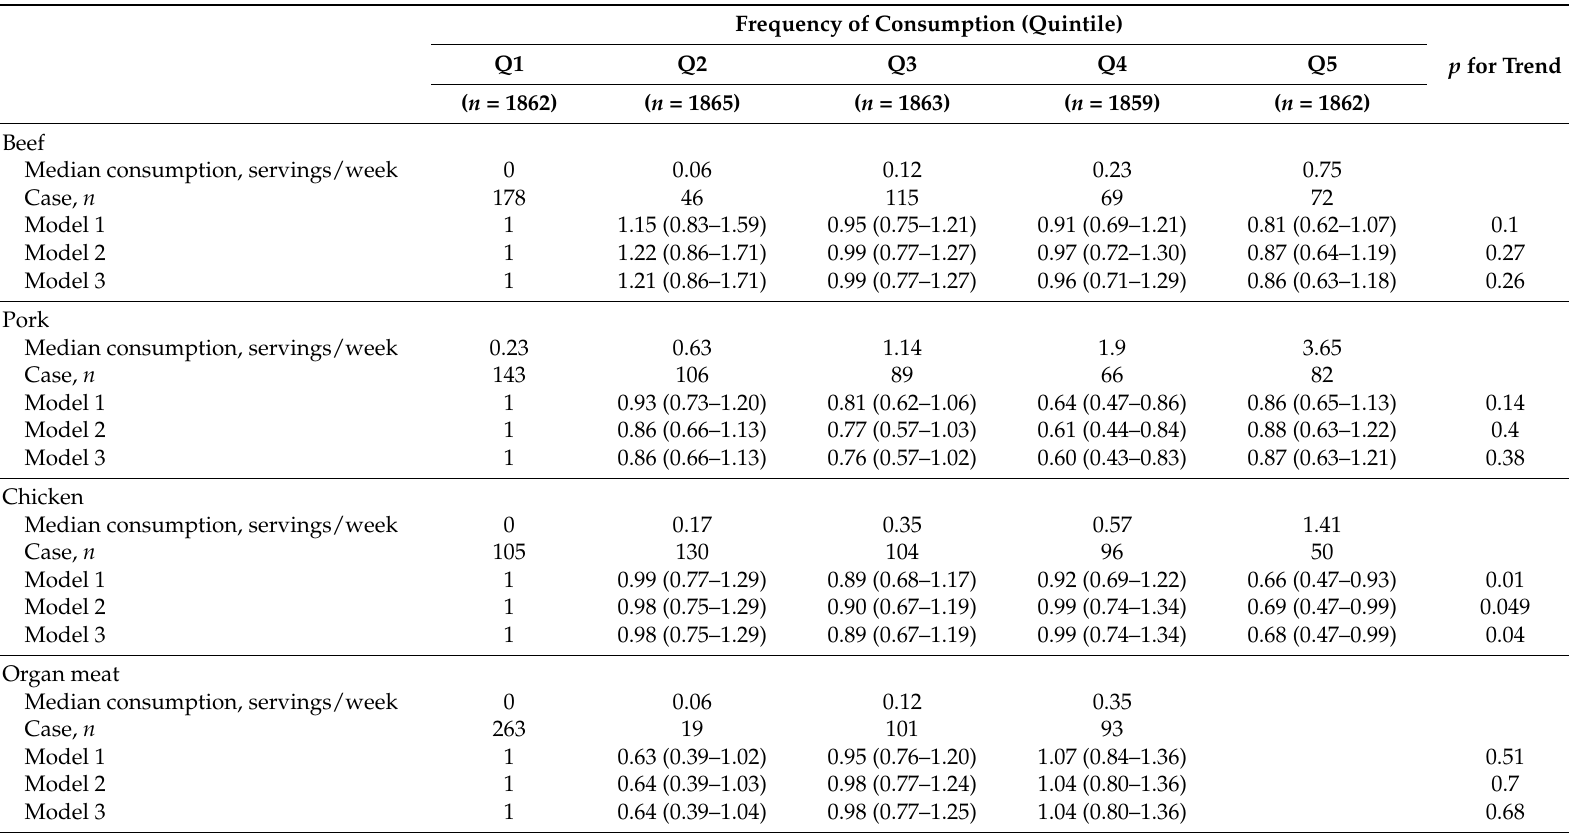
Table 3. Hazard ratios (95% confidence intervals) for CVD risk according to quintiles of consumption for each type of unprocessed meat in Korean